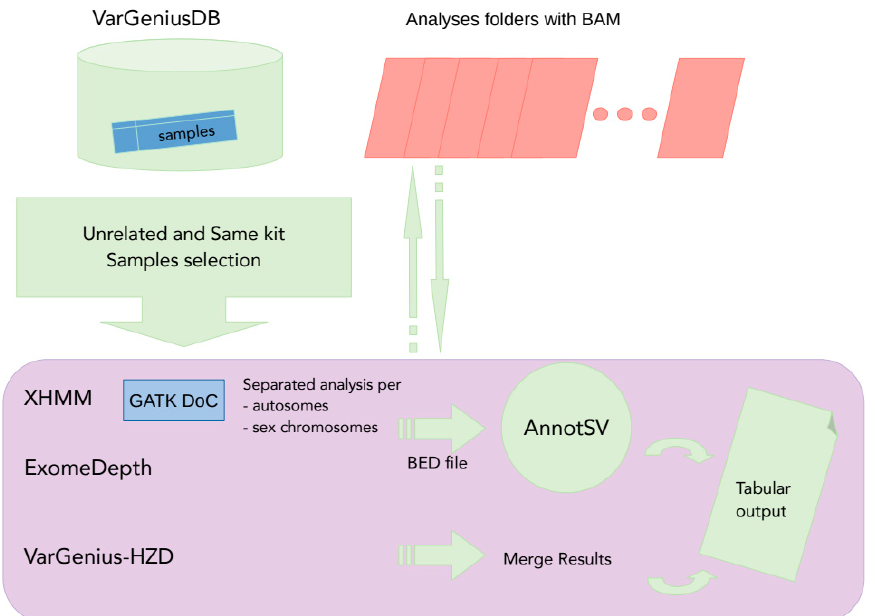
Figure 4. Flowchart of CNV detection and annotation pipeline in VarGenius. This is performed using XHMM, ExomeDepth, and the VarGenius-HZD algorithm. Several unrelated samples must be used for such analyses; thus VarGenius collects sample identifiers from the database querying for samples sequenced with the same target and considering the kinship. XHMM requires the use of GATK DepthOfCoverage with specific parameters. This is called for all samples parallelizing the execution within the cluster. Once all tools produced their calls, results are merged within a unique tabular output and are annotated using AnnotSV.